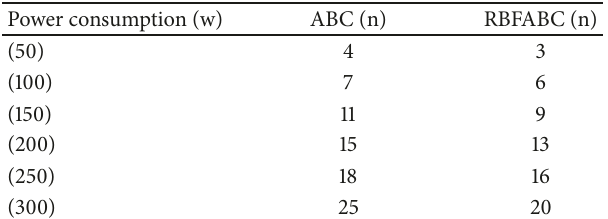
Table 2: Optimization results under a certain power.